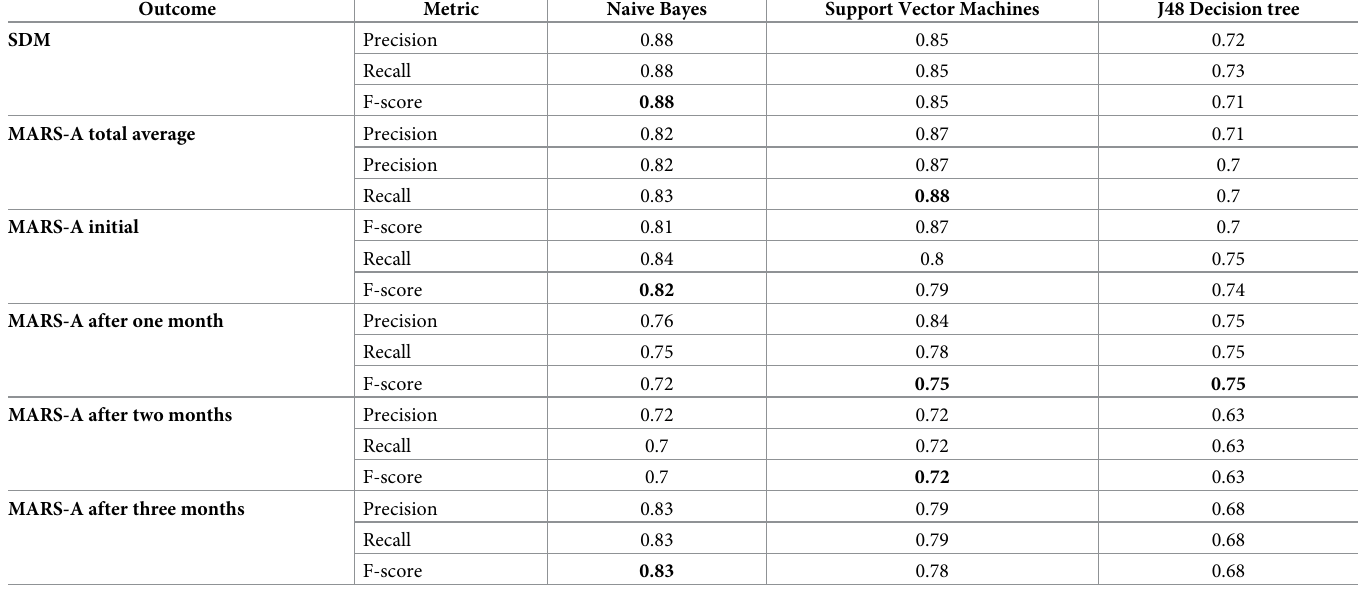
Table 1. Machine learning predictive